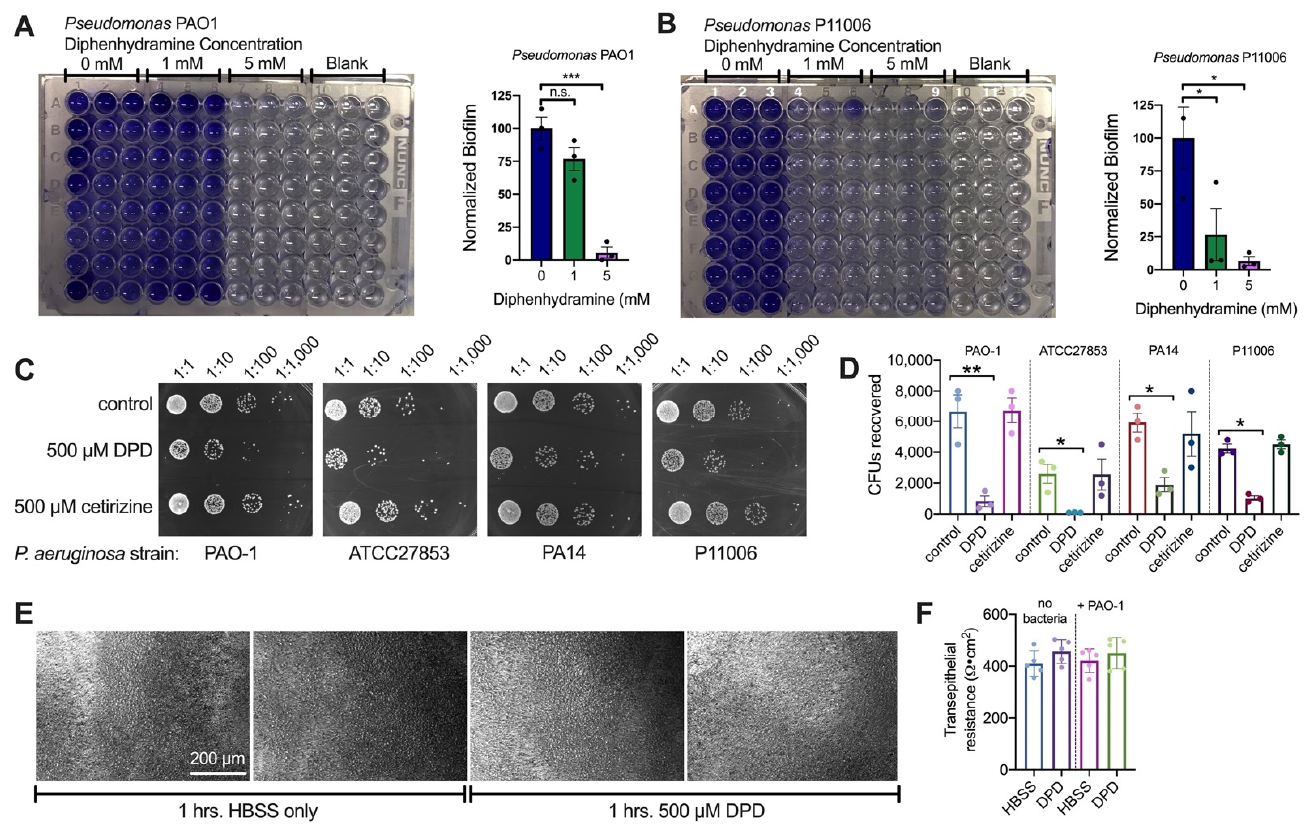
Figure 7. Diphenhydramine (DPD) inhibits P. aeruginosa biofilm production and attachment to CFBE cells. ( A , B ) Representative images of crystal violet staining showing diphenhydramine-reduced biofilm mass at 5 mM for lab strain PAO1 ( A ) and 1 mM for clinical strain P11006 ( B ). Other clinical strains used in Figure 4 did not form biofilms on 96-well plates and so could not be used in this assay. Representative images of the 96-well plate are shown. Data from three experiments are combined in bar graphs analyzed by one-way ANOVA using Dunnett’s post-test (* p < 0.05, *** p < 0.001). ( C ) Representative images of CFU counts following CFBE attachment assays as described in the text. DPD (500 µM) reduced the amount of bacteria recovered from CFBE cells while equimolar cetirizine did not. Control cells stimulated with media only. Lab strains PAO-1, ATCC27853 and PA-14 and clinical strain P11006 were used. ( D ) Quantification of results from independent experiments as in C. Significance by one-way ANOVA with Bonferroni post-test comparing all values to respective control; * p < 0.5, ** p < 0.01. ( E ) Representative phase contrast images of CFBE ALIs incubated in HBSS ± 500 µM DPD (1 h; 37 °C). No signs of epithelial break down were observed. Representative of 6 ALIs per condition from independent experiments. ( F ) Transepithelial resistance was measured ±DPD stimulation as in E. No significant difference was observed by one-way ANOVA.